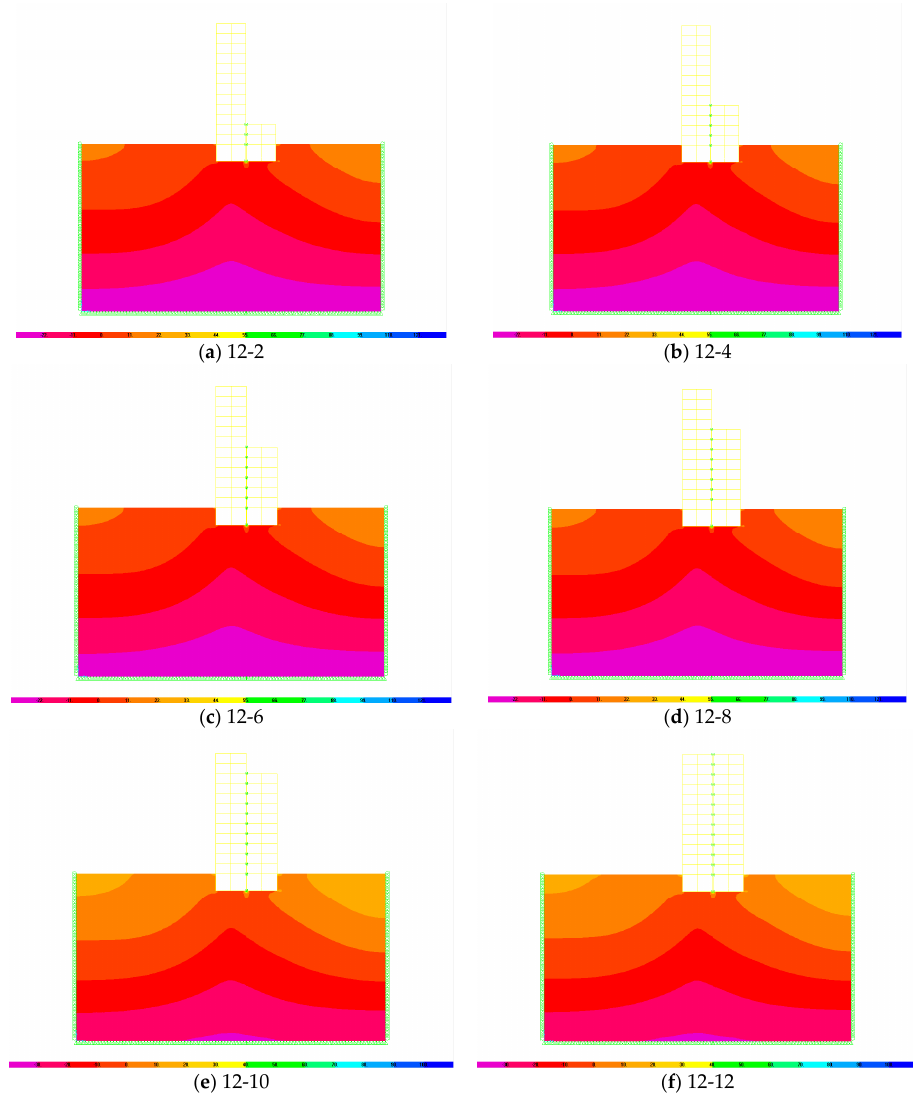
Figure 20. Lateral soil stresses (KN/m 2 ) for the two adjacent buildings with equal foundation levels.